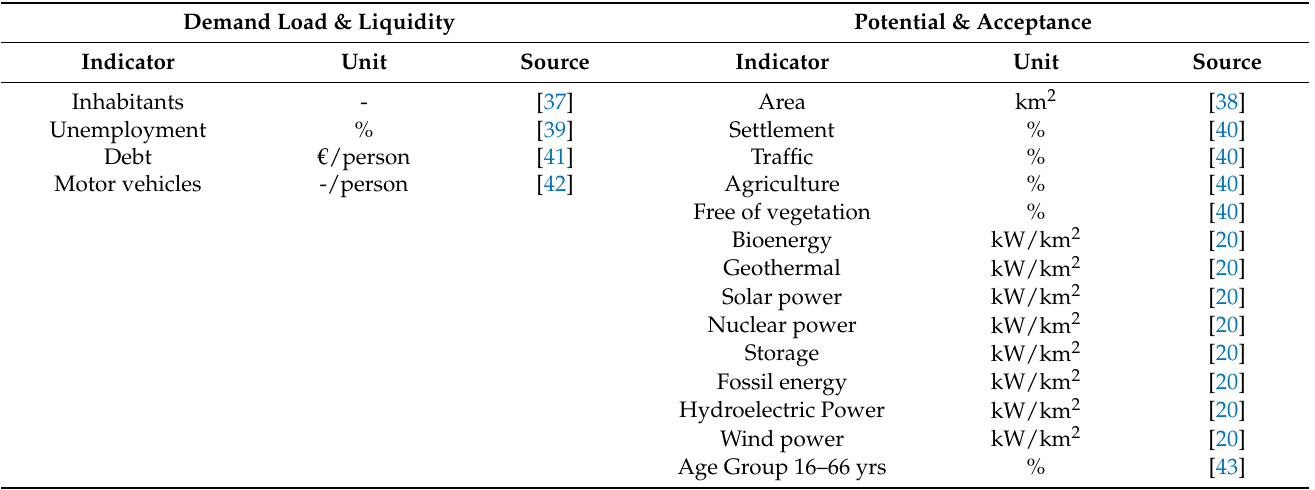
Table 6. Indicators for cluster analysis.